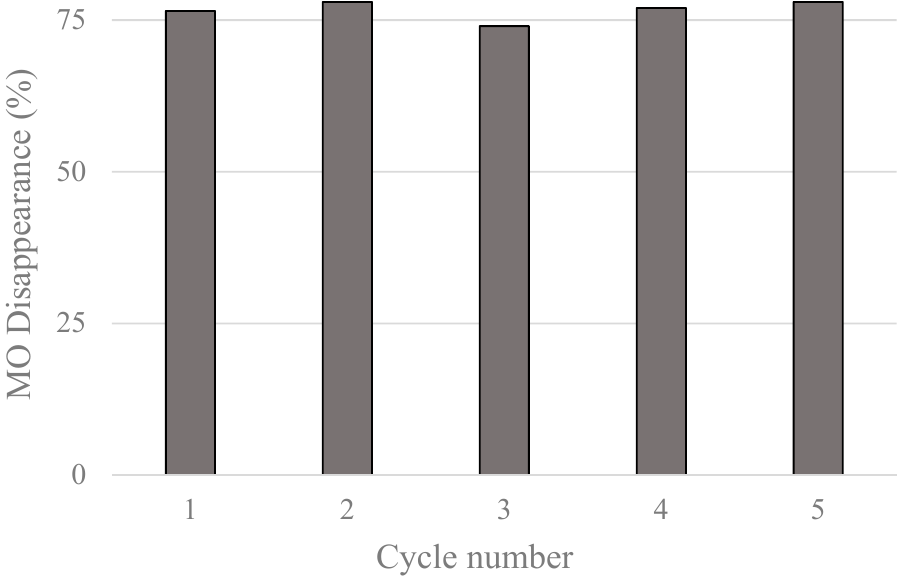
Figure 8. MO disappearance (%) obtained by irradiating (4 h, λ ≥ 360 nm) the same FTO supported TiO 2 thin film during five consecutive photocatalytic runs.